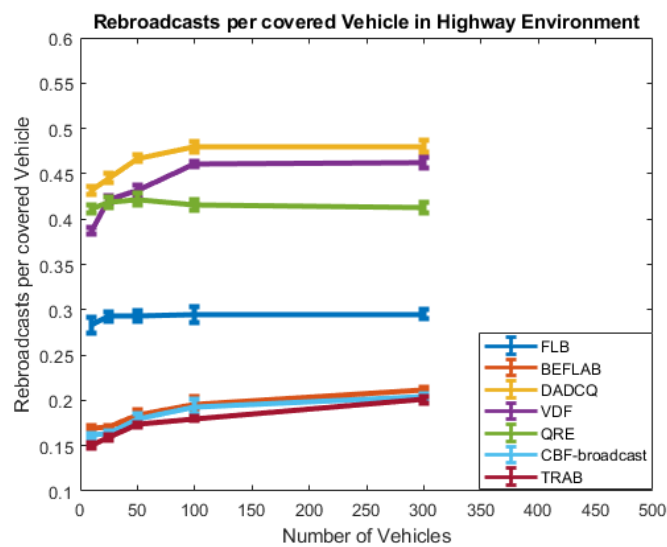
Figure 10. Highway rebroadcasts per covered vehicle.